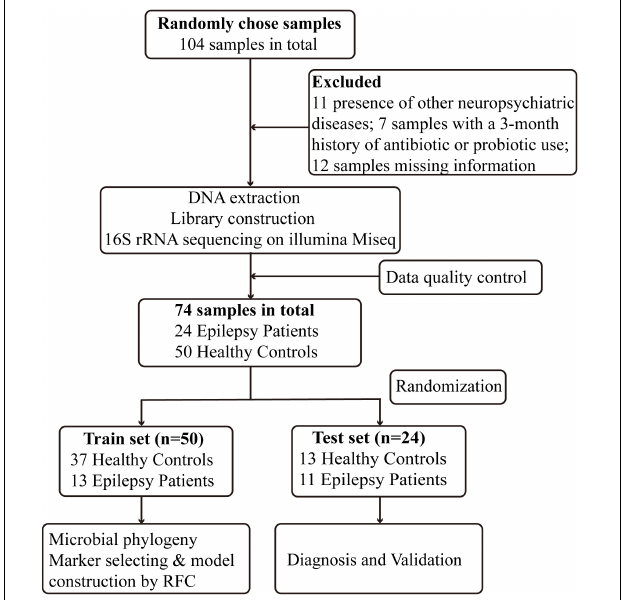
FIGURE 1 | Study design and flow diagram. A total of 104 fecal samples from Central China were collected. After a strict diagnosis and exclusion process, 24 patients with epilepsy and 50 healthy controls were included and randomly divided into the train set ( n = 50) and test set ( n = 24). In the train set, we characterized gut microbiome among 13 epilepsy patients and 37 healthy controls and identified microbial markers and constructed epilepsy classifier by random forest model. In test set, 13 healthy controls and 11 epilepsy patients were used to validate diagnosis efficacy of epilepsy classifier. RFC, random forest